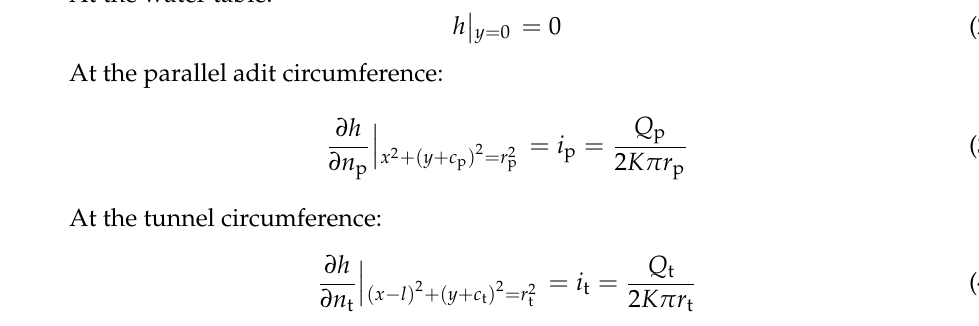
where h is the total head, given by the sum of the elevation head and pressure head (kinetic head is neglected because groundwater flow is assumed to be slow): h = u / γ w + y , u is the pore water pressure, γ w is the unit weight of water, u / γ w is the pressure head, and y is the elevation